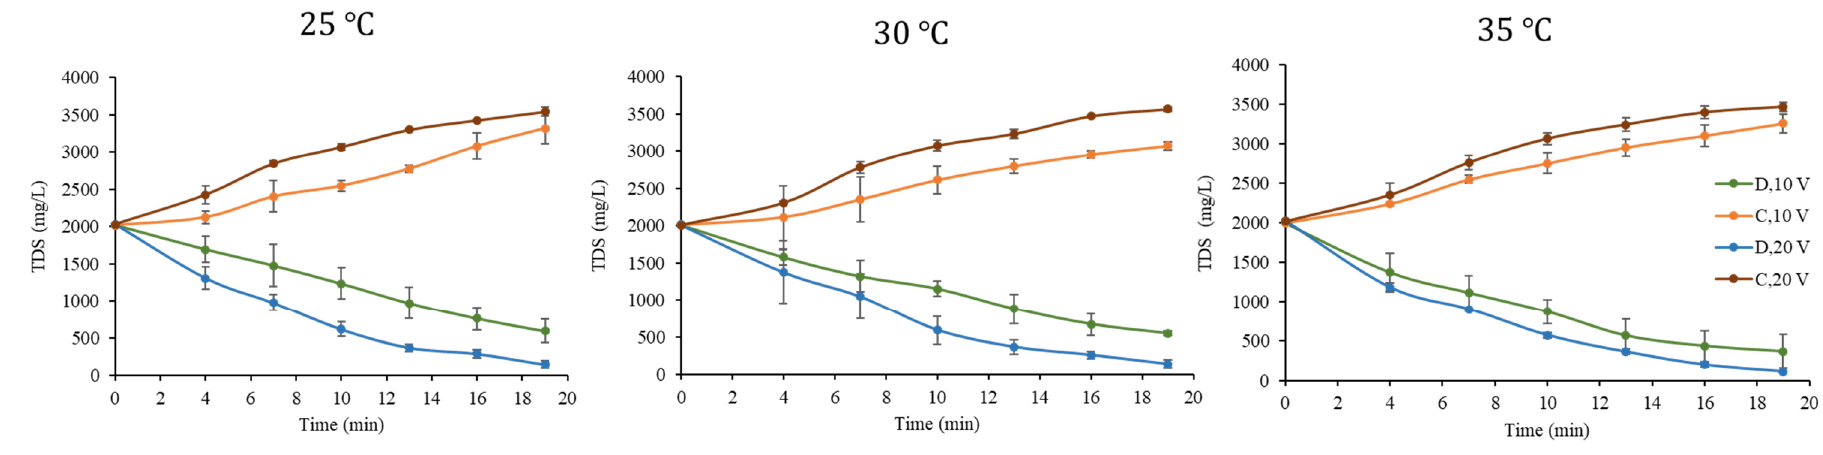
Figure 4. The evolution of the TDS in tests of 2000 mg/L TDS.